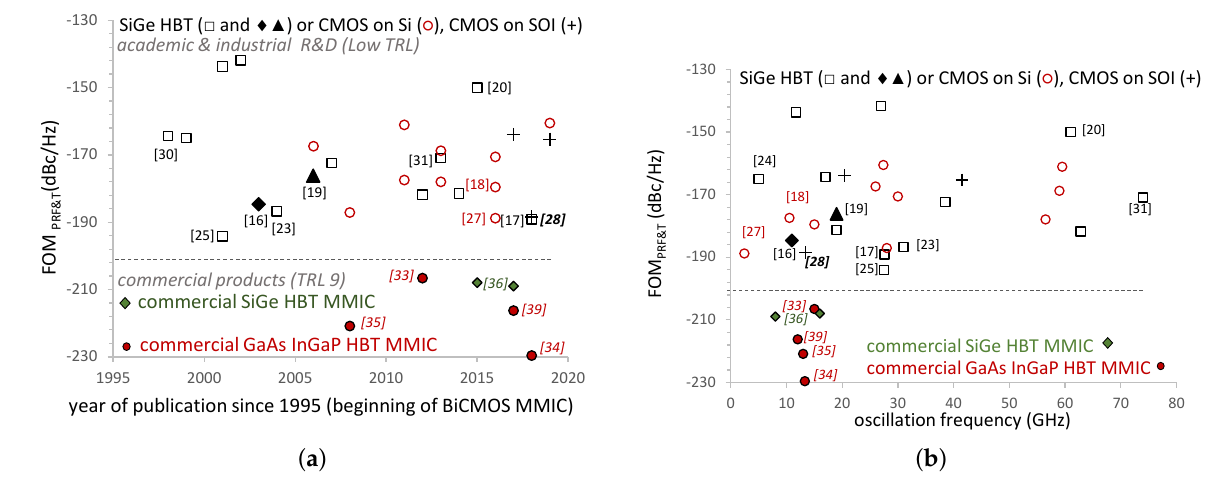
Figure 11. Evolution of the FoM P metric (Equation (4)) ( a ) with the year of publication ( b ) RF & T versus the oscillation frequency. Some references used in the paper are noted close to the associated symbol [16–40].